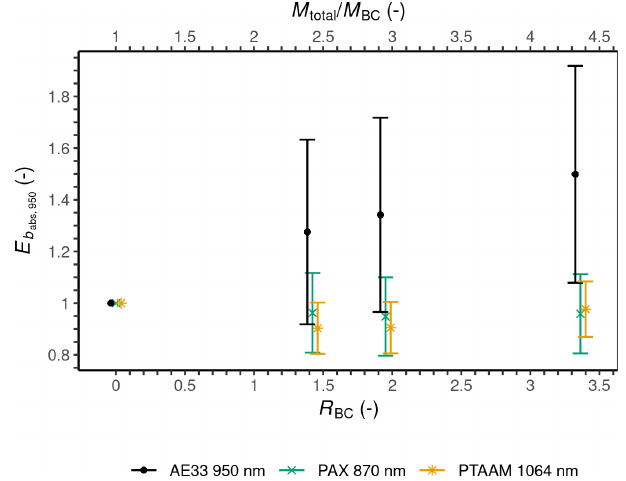
Figure 5. Measurements obtained with setup 0.1. Absorption en- hancement factor E abs (950nm) as a function of total mass to BC mass ratio and R BC . For the calculation of E abs , all b abs values had been converted to a wavelength of 950nm using the absorption Ångström exponents determined from the 880 and 950nm b abs val- ues from the Aethalometer. All b abs values are also scaled by the number concentration. The values are listed in Table S4. The data points have been slightly shifted along the x axis to improve the readability of the graph. The error bars correspond to uncertainties for k = 1 (68% confidence interval; see text for more